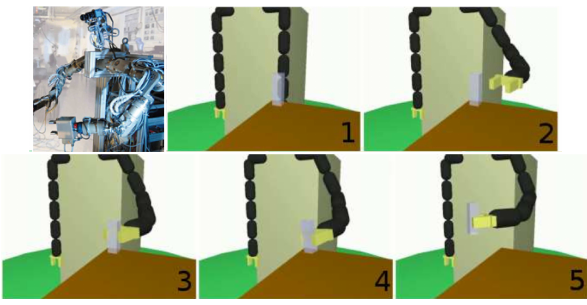
Figure 4. The original CCRL robot (left). From left to right, a typical solution which worked well in the object grasping task is shown: 1. Initial pos- ture. 2. Approach. 3. Enclose. 4. Take hold. 5.